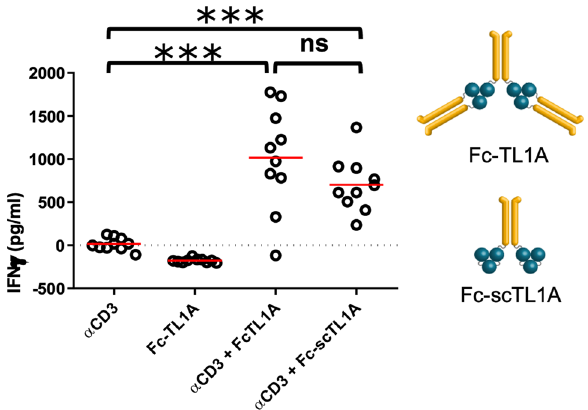
Figure 3. Fc-TL1A ligands activate T cells in vivo . Mice were treated with anti-CD3 antibody and Fc-TL1A or Fc-scTL1A, and serum concentrations of IFNg were measured. IFNg levels are shown in pg/mL and constructs are indicated on the graph. Stastical significance was determined using an unpaired T-test for each construct using Graphpad Prism (Version 9): https:// www. graph pad. com/ scien tific- softw are/